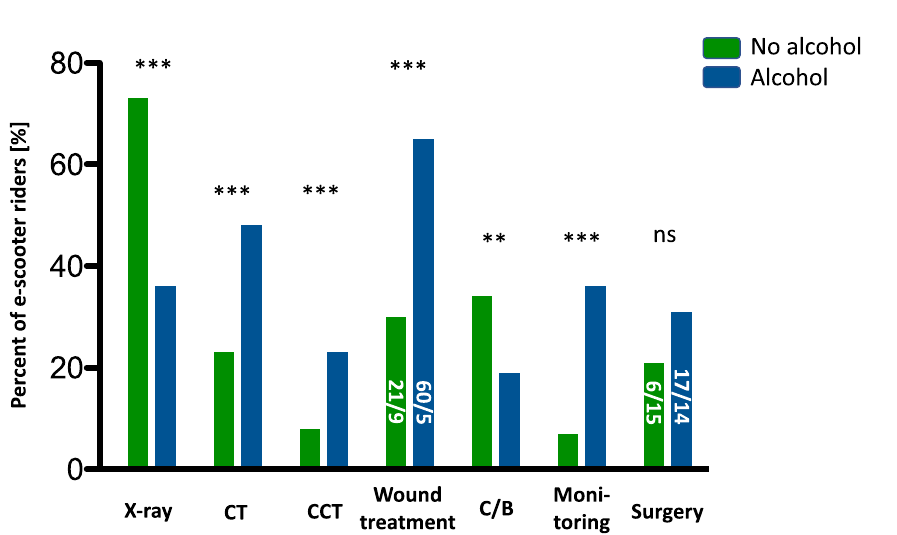
Figure 4. Bar graph depicting sober e-scooter riders vs. those under the influence of alcohol. Depicted as bars in percent of total of those who received a standard radiograph (X-ray), computed tomography (CT), cranial computed tomography (CCT), wound treatment, cast or brace (C/B), 24-h continuous vital sign monitoring, and surgery. Wound treatment and operations divided for maxillofacial surgeon (top) / orthopaedic surgeon (bottom) in percent. Statistical analysis with Mann–Whitney test (* p < 0.05, ** p < 0.01, *** p <